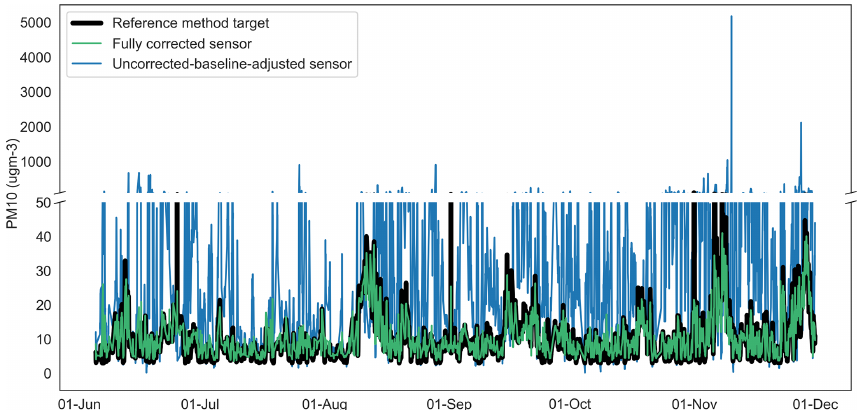
Figure 10. Time series of uncorrected-baseline-adjusted sensor, fully corrected sensor and reference method observations for PM 10 at Oxford St Ebbe’s for 2020. ugm-3: µgm − 3